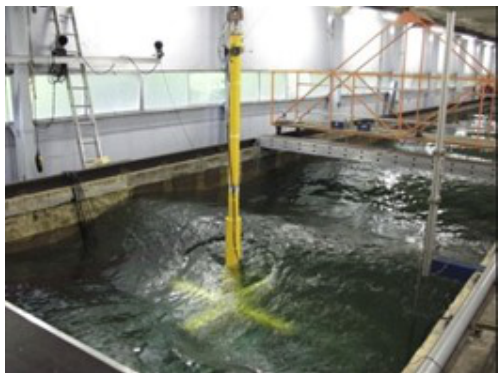
Figure 1. TLP floating offshore wind turbine: the specimen under extreme irregular waves (reprinted from Oguz et al., [5] copyright (2022), LN 5311720742150, with permission from